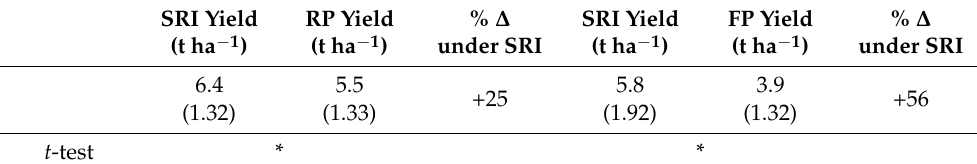
Table 1. Percent change in rice grain yield under SRI compared with RPs and FPs.